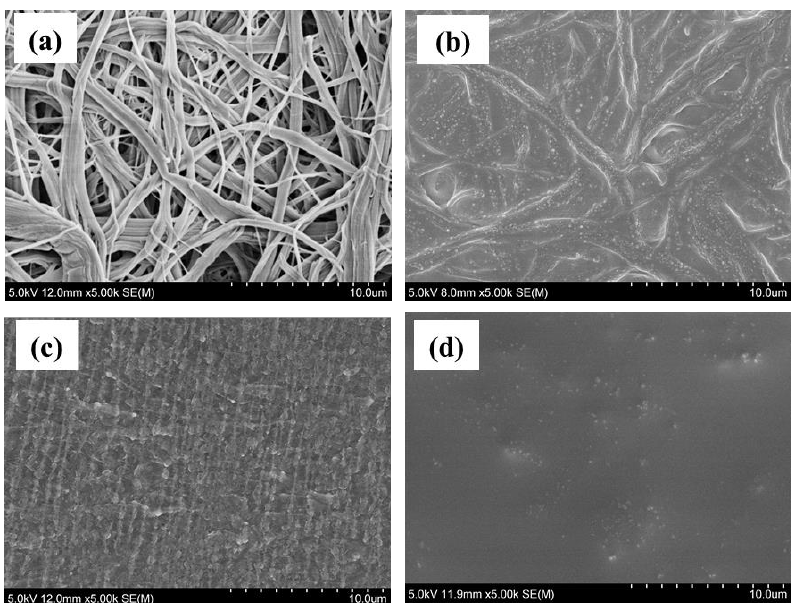
Figure 12. SEM images of ( a ) the original cellulose membrane and ( b ) the cellulose composite isolation membrane after 50 cycles, and ( c ) the original lithium electrode and ( d ) the lithium electrode after 50 cycles.